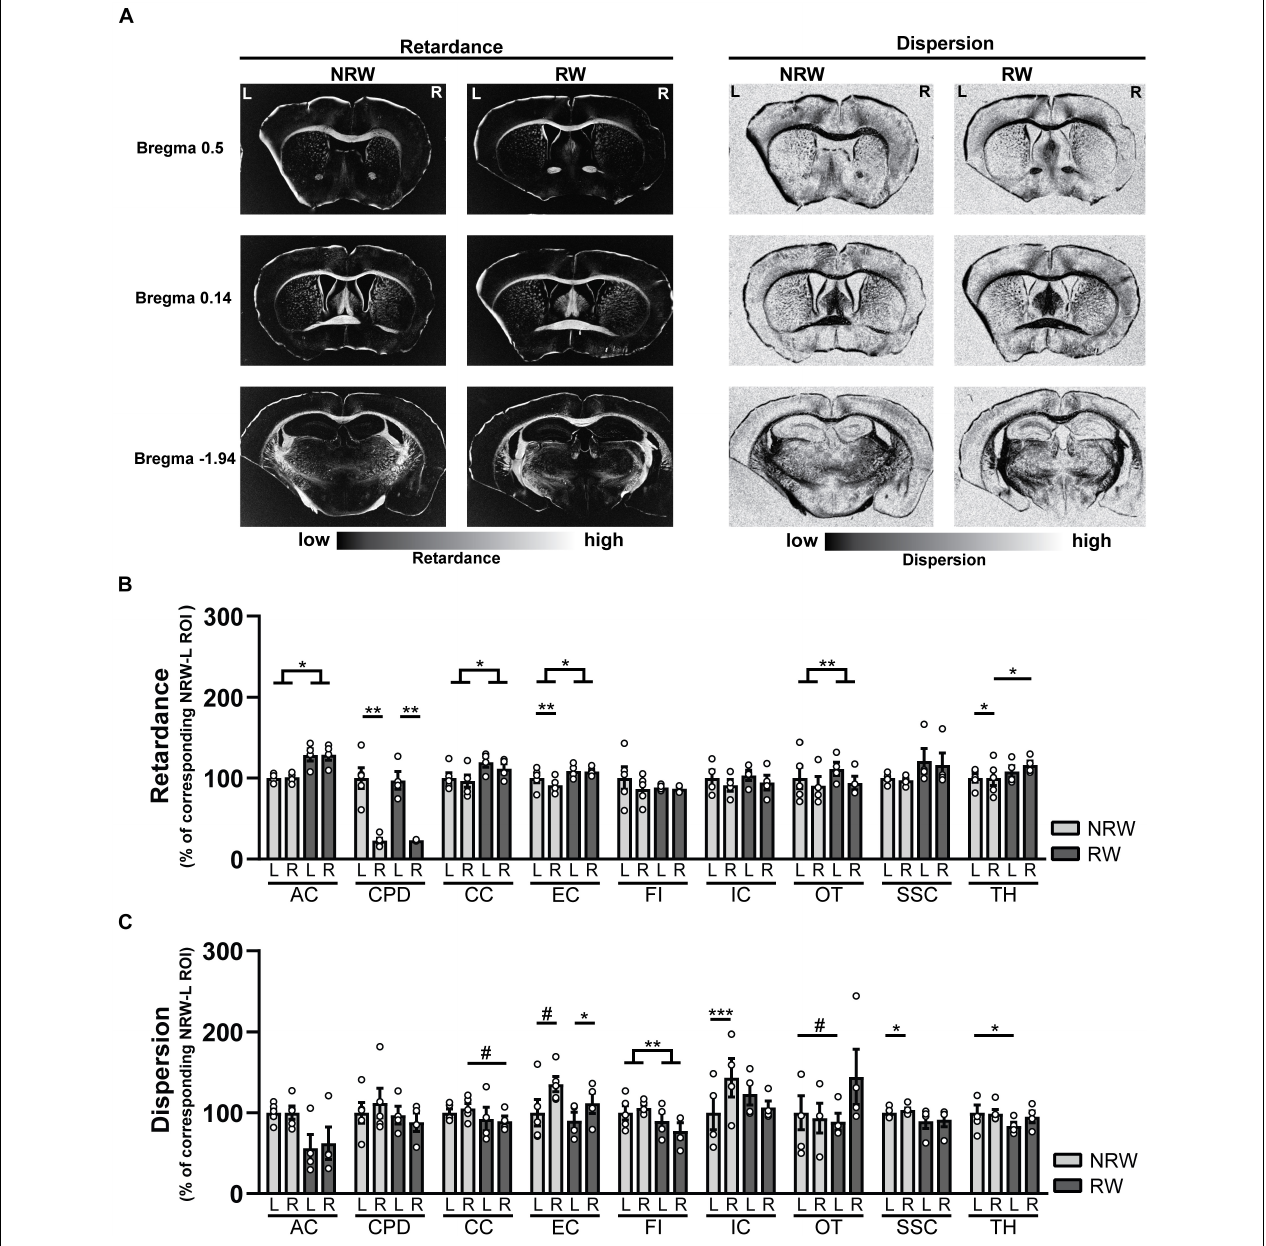
FIGURE 8 | (A) Representative images of retardance and dispersion maps of both running wheel (RW) and no running wheel mice (NRW) 1 week post-stroke, taken at the level of bregma 0.14, 0.5, and –1.94. (B) Retardance and (C) dispersion assessed with polarized light imaging (PLI) in the ipsilateral (R: right) contralateral (L: left) hemisphere of several ROI (AC: anterior commissure, CPD: cerebral peduncle, CC: corpus callosum, EC: external capsule, FI: fimbria, HI: hippocampus, IC: internal capsule, MC: motor cortex, OT: optic tract, SSC: somatosensory cortex, TH: thalamus). RW: N = 5, NRW: N = 4; values represented in mean ± SEM. # 0.05 < p < 0.08 (tendency); * p ≤ 0.05; ** p ≤ 0.01; *** p ≤ 0.001.